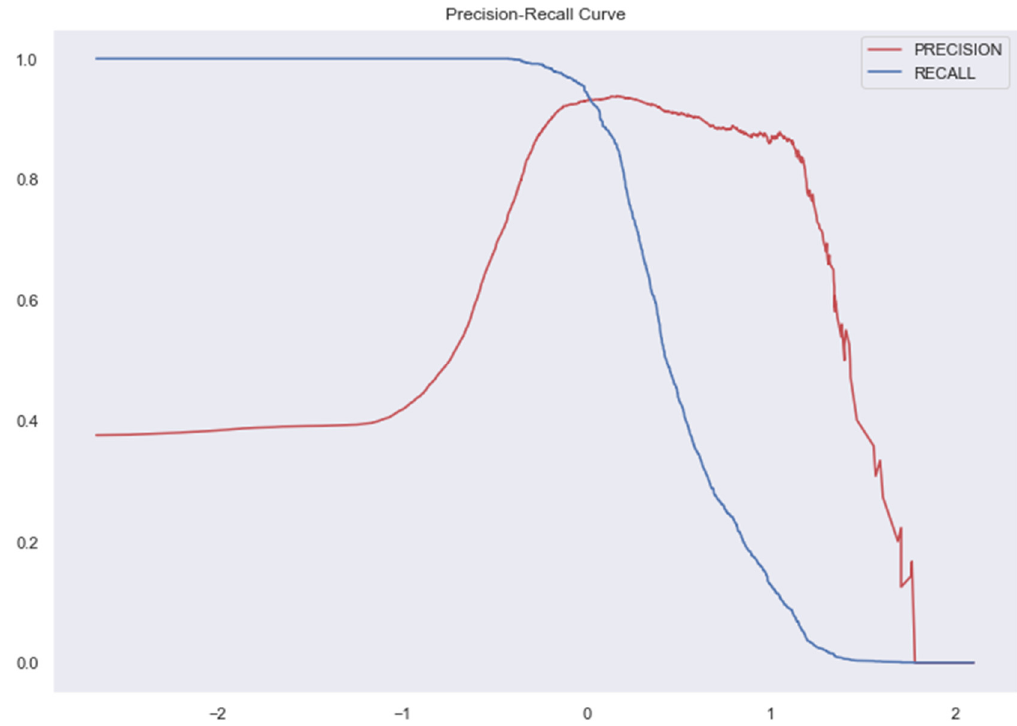
Figure 8. Precision-Recall Curve for Ridge Classifier. AUC for Ridge Classifier–0.94 (The AUC curve for RC cannot be plotted due to the nature of the algorithm.).